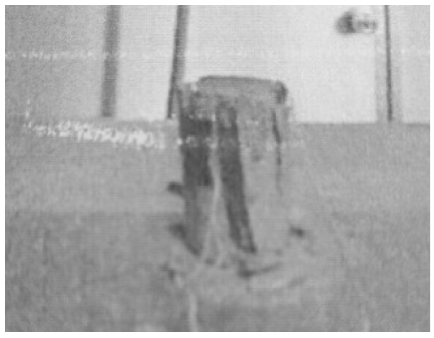
Figure 5: Failure mode of the granite stone